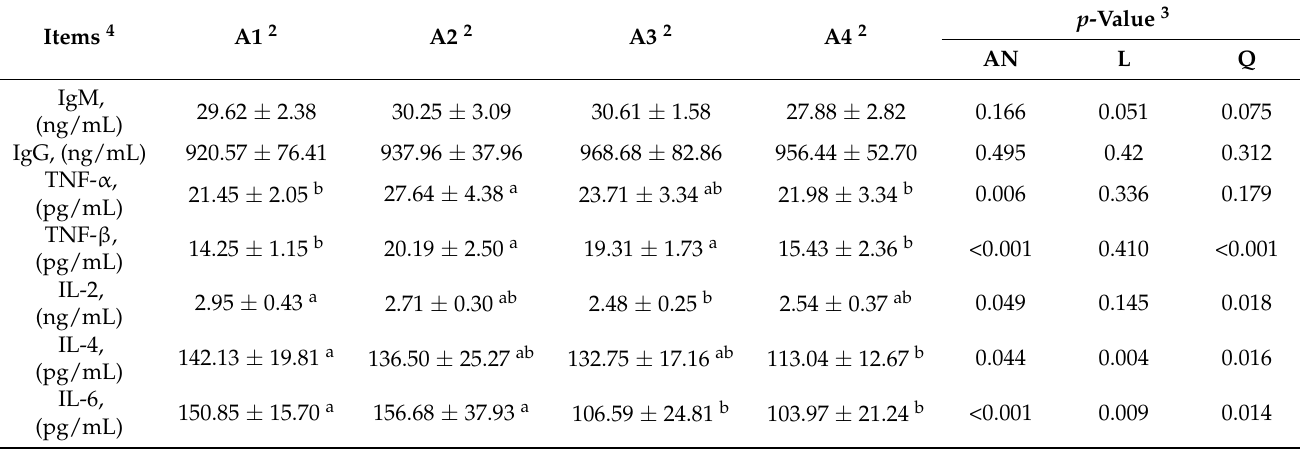
Table 7. Immunity and inflammation indexes in the serum of laying hens on week 12 (mean ± STD 1